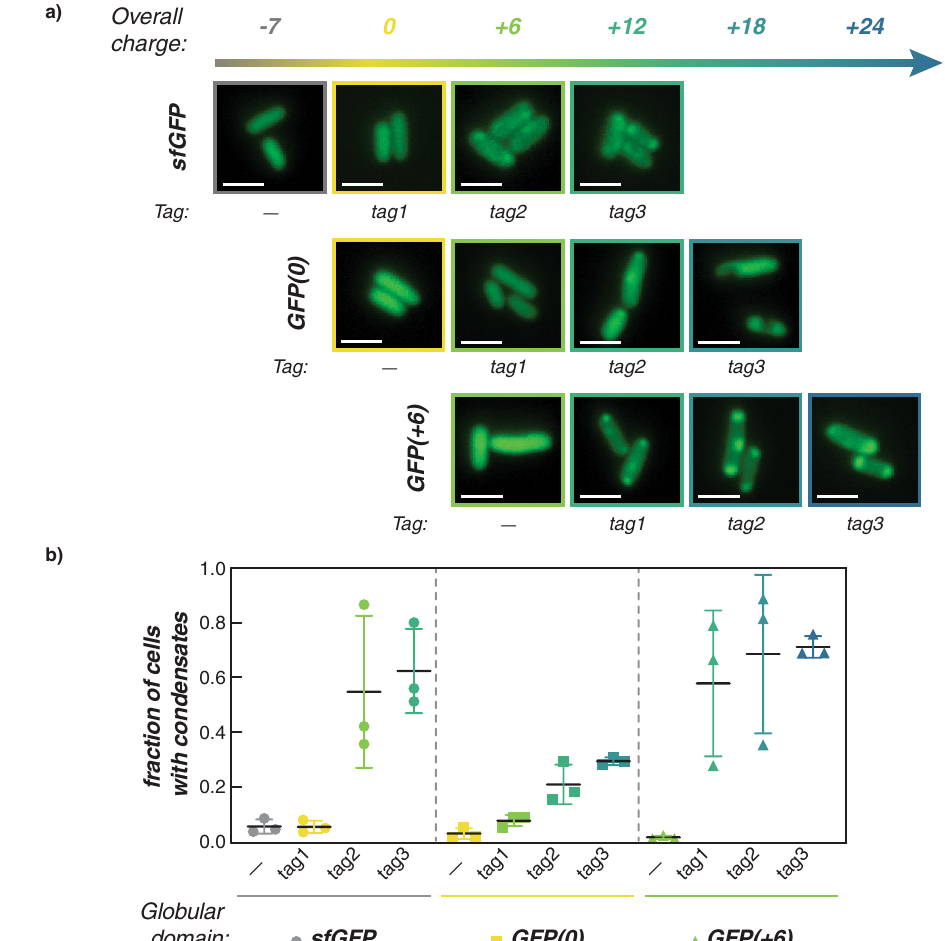
Fig.2|Intracellularphaseseparationdependsonglobulardomainandpeptide tag charge. a Representative microscopy images of E. coli cells expressing each GFP variant at 24h post-induction (additional time points can be found in Sup- plementaryFigs.2 – 8,10and11).Generally,GFPvariantswithanoverallnetcharge ≥ +12formedintracellular condensates. Additionally, sfGFP-tag2 (net charge +6) was also observed to form condensates at 24h. Scale bar is 2 µ m. b Analysis of n >400 cells per GFP variant con fi rms that a net charge of ≥ +12 resulted in condensate